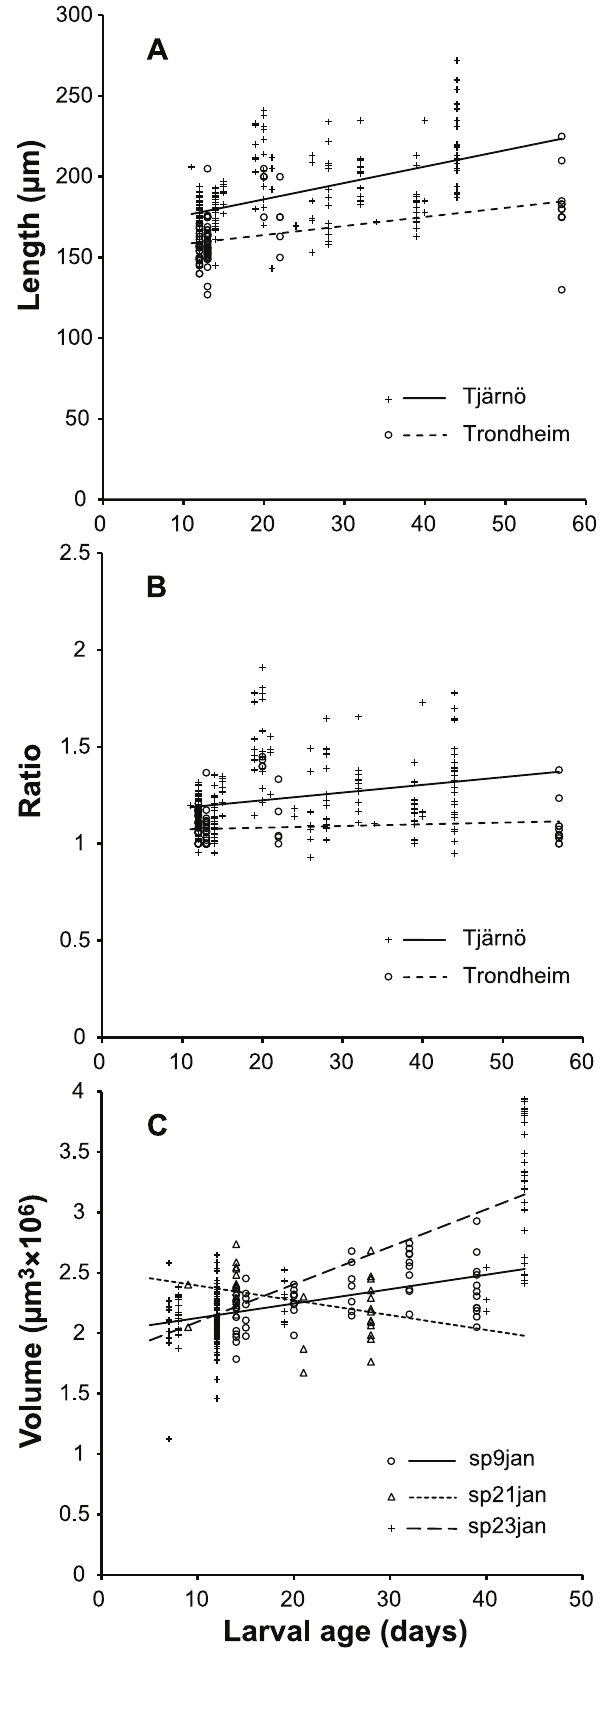
Figure 6. Size measurements of Lopheliapertusa larvae ( $ 10 days) from the Tja¨rno¨ and Trondheim laboratories. Larval length ( A ), length to width ratio ( B ), and volume of larvae from separate larval cultures at Tja¨rno¨ during the spawning 2013 ( C ). Lines are regression lines and the x-axis shows larval age in days after spawning. Batch sp23jan was fed on day